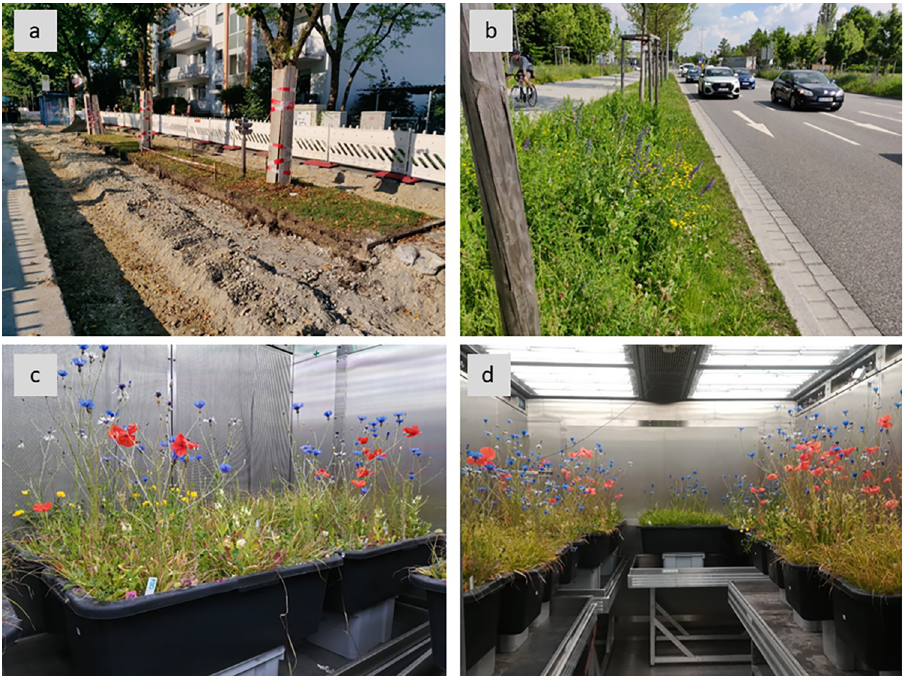
Fig 1. Urban road verge grasslands mimicked in mesocosms in climate chamber experiment. (a) Road verge grasslands often occur on heavily sealed ground with shallow soil and using few grass species. (b) Restored grasslands in road verges are species-rich and adapted to urban conditions to improve ecosystem services delivered. (c) In the mesocosm experiment, forb species used for restoring urban road verges were sown, and the communities developed under similar conditions (e.g., substrate characteristics, limited soil depth, and surrounding sealed space). (d) Mesocosm grasslands of varying functional compositions were submitted to two climate change scenarios in the climate chambers of an ecotron facility. Pictures of road grasslands (a) and (b) were taken in Munich, Germany (courtesy of Simon Dietzel); pictures (c) and (d) were taken at weeks 9 and 10 of mesocosm development in chambers submitted to RCP8.5 and RCP2.6, respectively. For a better overview of the communities’ development under the two tested scenarios, see S2